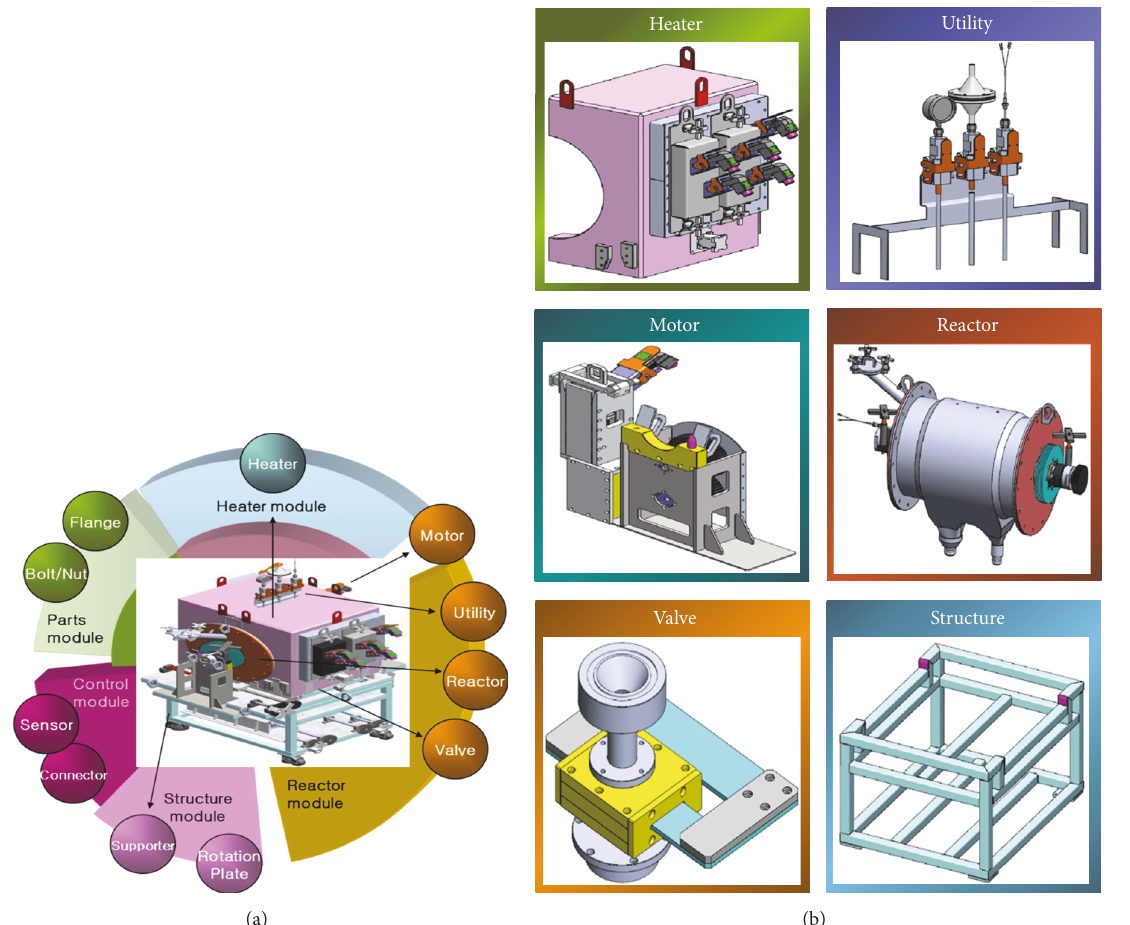
Figure 14: Modular design for a remotely operated voloxidizer: (a) main modules of the voloxidizer; (b) design modules.